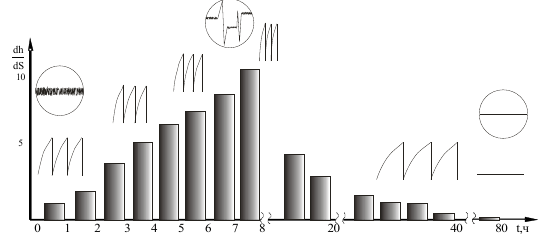
Fig 3. AE signal histogram for the all period of tests with cuts of the diagram and form of AE signal on the shield of an oscillograph